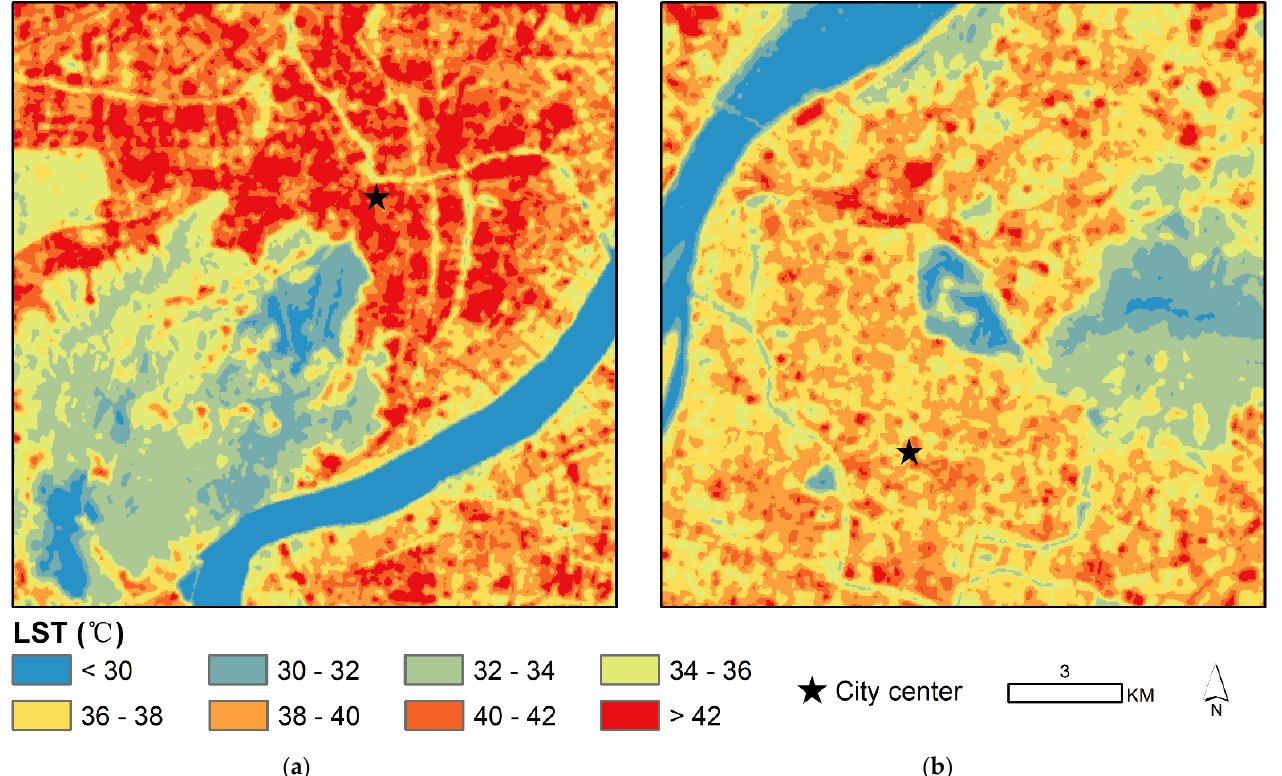
Figure 3. The land surface temperature (LST) maps of ( a ) West Lake and its neighboring areas in Hangzhou, and ( b ) Xuanwu Lake and its neighboring areas in Nanjing.